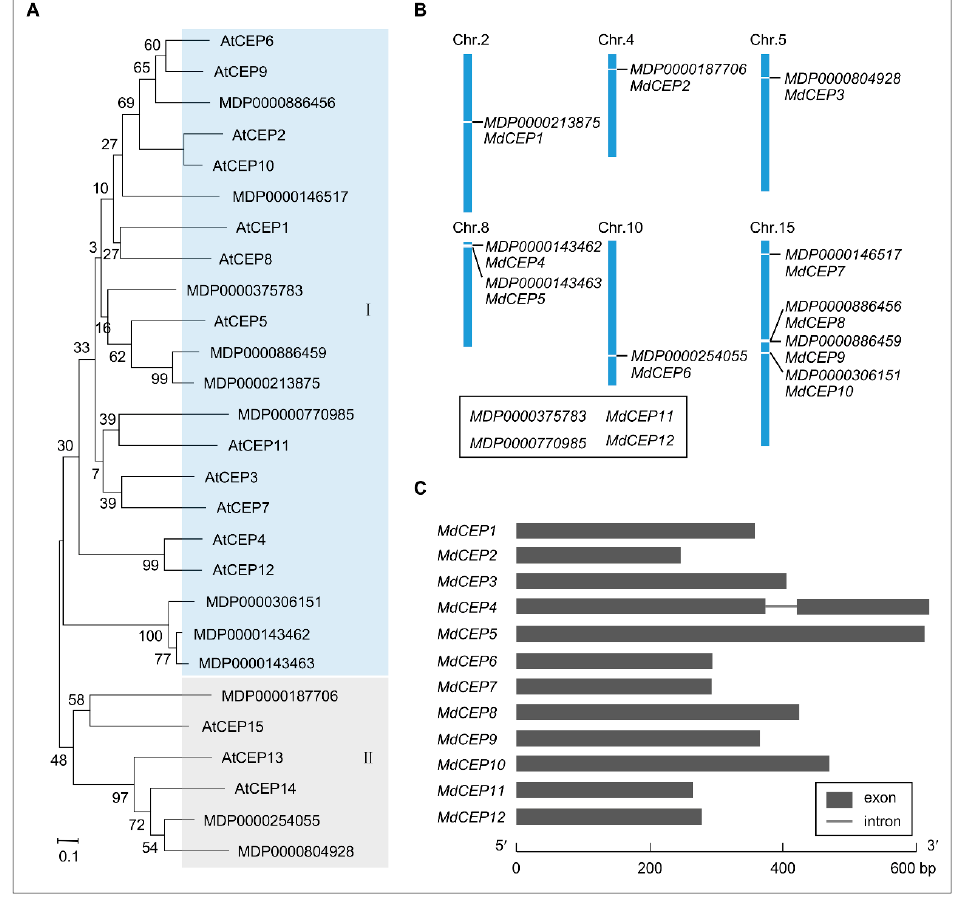
Figure 1. Identification and phylogenetic analysis of MdCEPs in apple. ( A ) The phylogenetic relationship of 15 AtCEPs and 12 MdCEPs. The phylogenetic tree based on CEP domain is created with MEGA7 by the neighbor-joining method and the bootstrap tests are indicated on the tree. CEP, C-terminally encoded peptide. ( B ) The chromosome location of MdCEPs in apple. The unanchored contigs are marked in the open squares. MdCEP11 and MdCEP12 are situated on unanchored contigs (Apple’s whole genome sequencing is incomplete). ( C ) The gene structures of MdCEPs in apple.